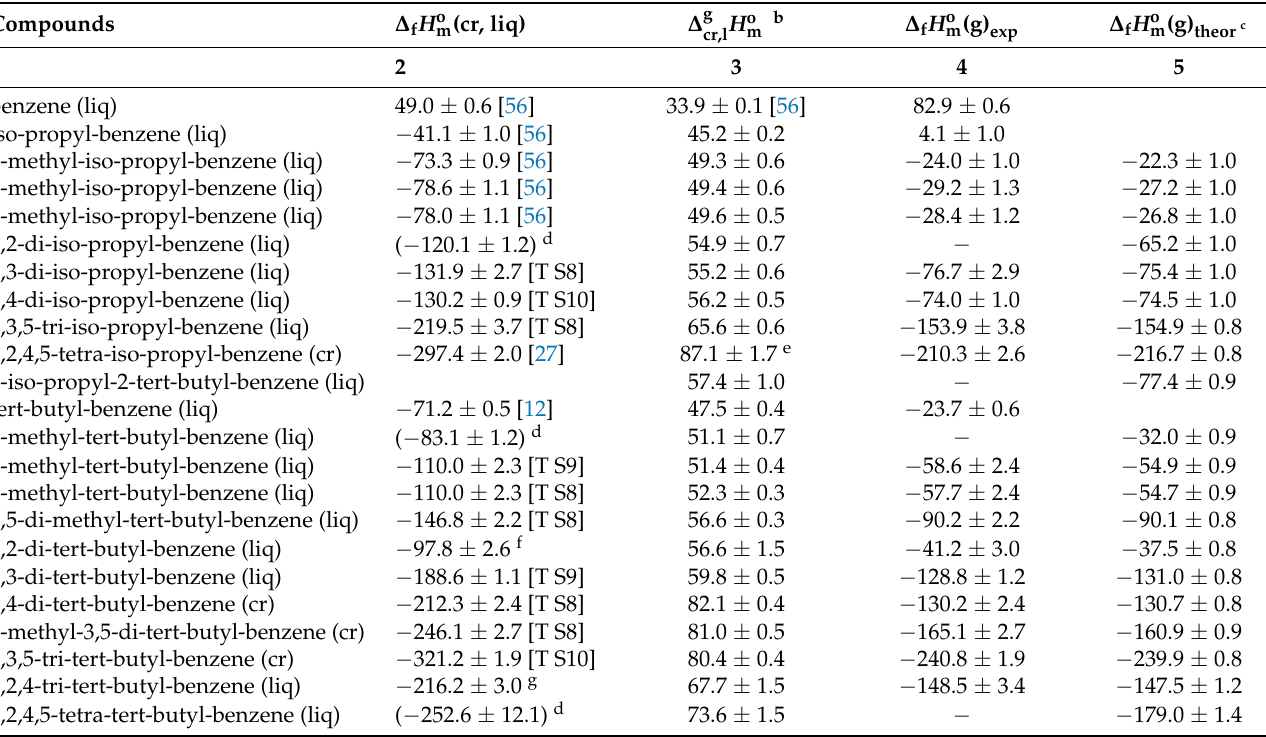
Table 8. Thermochemical data for iso-propyl- and tert-butyl-benzenes at T = 298.15 K ( p ◦ = 0.1 MPa, in kJ · mol − 1 ) a .